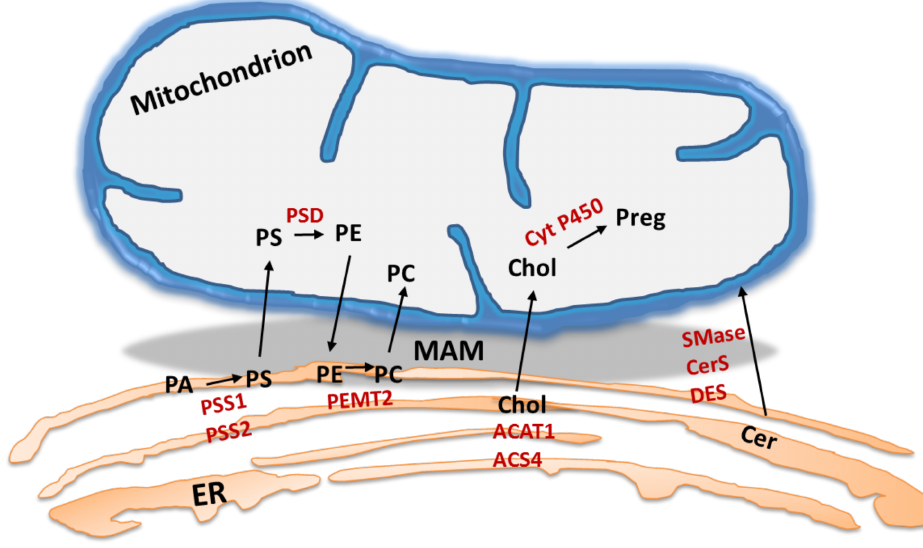
Figure 3. Lipid trafficking at the mitochondria-associated membranes. The ER-mitochondria interface fosters the transport of phospholipids, cholesterol (Chol) and ceramides (Cer). Particular lipid species exodus is integrated by a network of MAM residing enzymes (marked in red), including PSS1, PSS2, PSD, PEMT2, cytochrome P450, SMase, CerS and DES. Abbreviations: PA, phosphatidic acid; PS, phosphatidylserine; PE, phosphatidylethanolamine; PC, phosphatidylcholine; Preg,